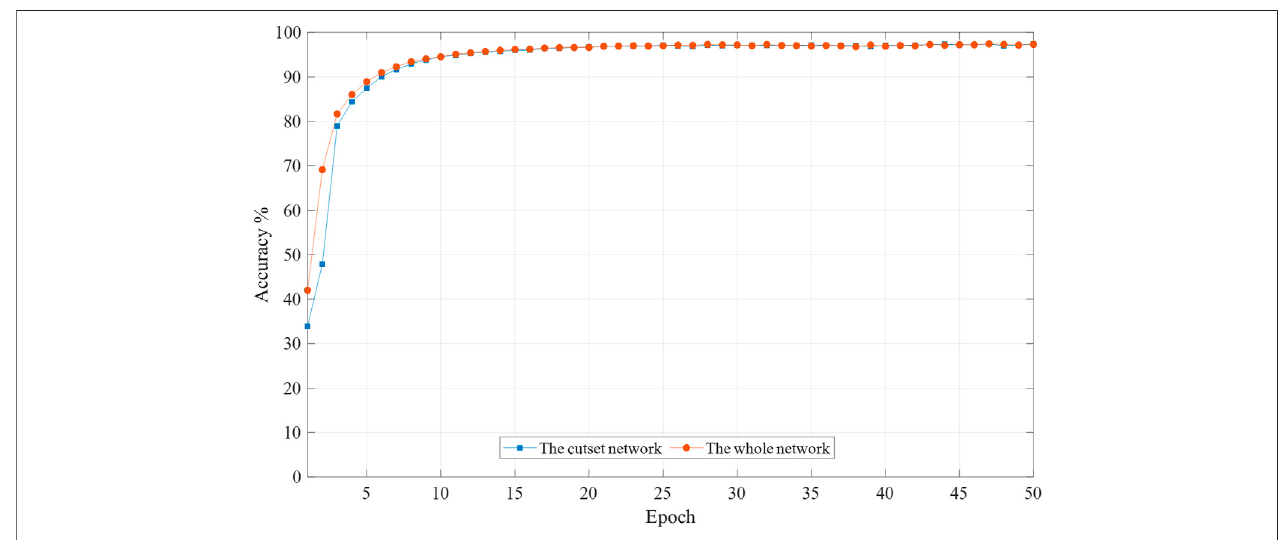
FIGURE 10 | Mean accuracy of reconstructed data by different network forms during the training process (IEEE 118-bus system).